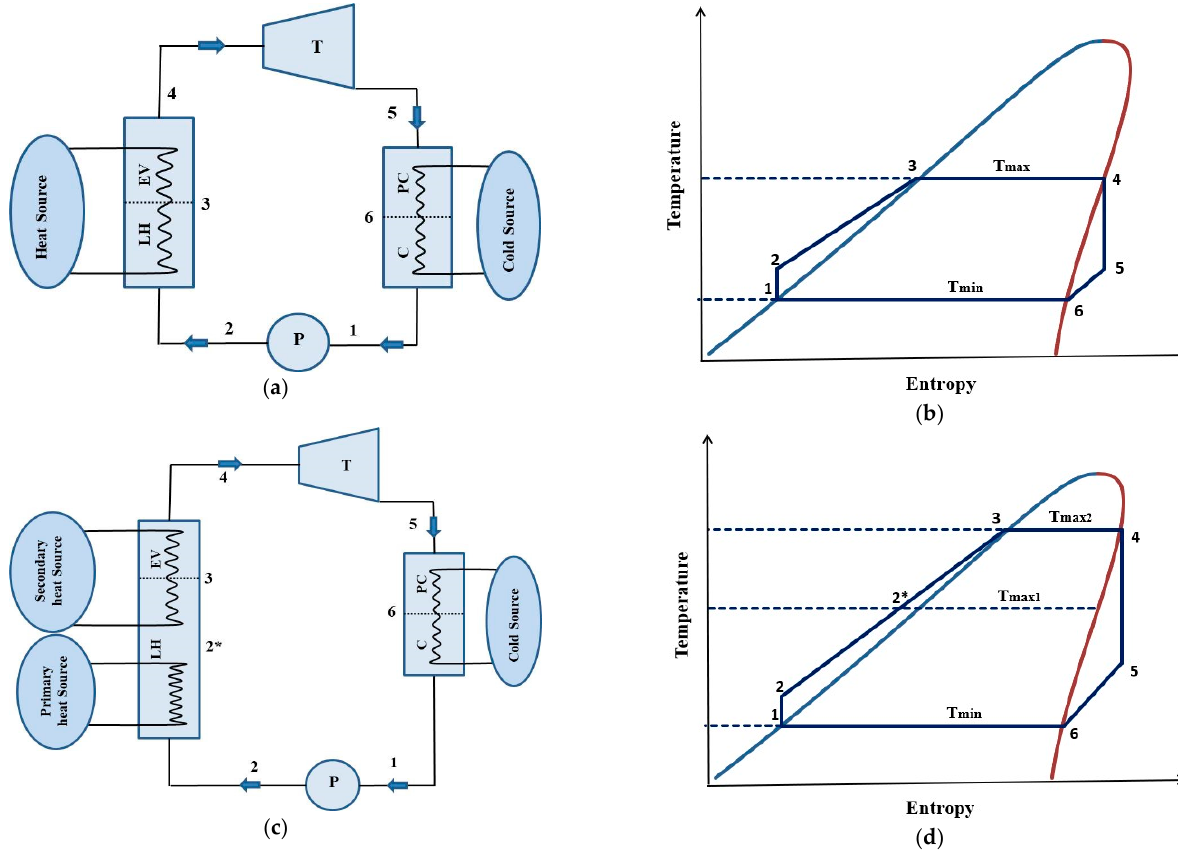
Figure 1. Schematic layouts and T-s diagrams for simple single-source ( a , b ) and hybrid ( c , d ) ORC systems. P: pump; LH: liquid heater; EV: evaporator; T: turbine or expander; PC: pre-cooler; C: condenser.